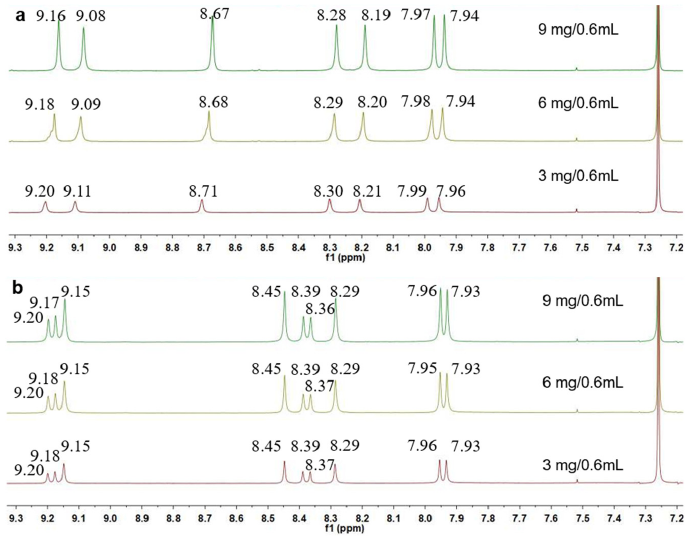
Figure 7. Concentration ‐ dependent 1 H NMR in CDCl 3 of ( a ) BBP 12 and ( b ) DBP